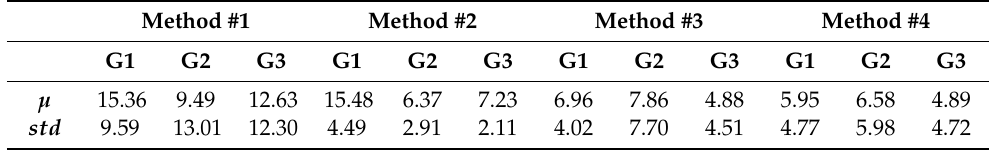
Table 11. Impact of noise on the performance of the proposed approach. Statistical results for the PE